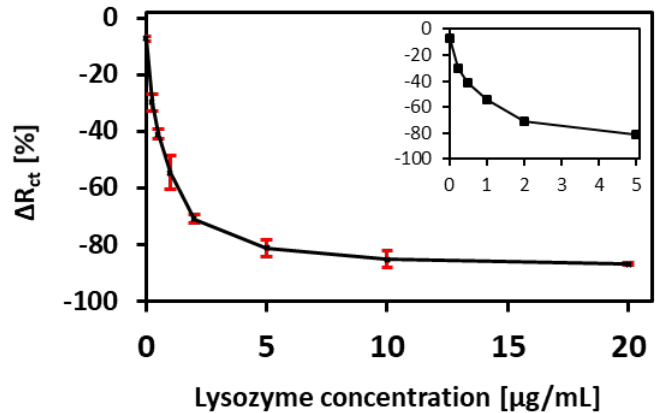
Figure 11. Relative change in charge transfer resistance (R ct ) after lysozyme exposure with varying concentrations (0, 0.25, 0.50, 1, 2, 5, 10, and 20 µg/mL). Error bar shows 1 standard deviation with n = 3. The inset graph shows the magnified plot for low concentration range from 0 to 5 µg/mL.